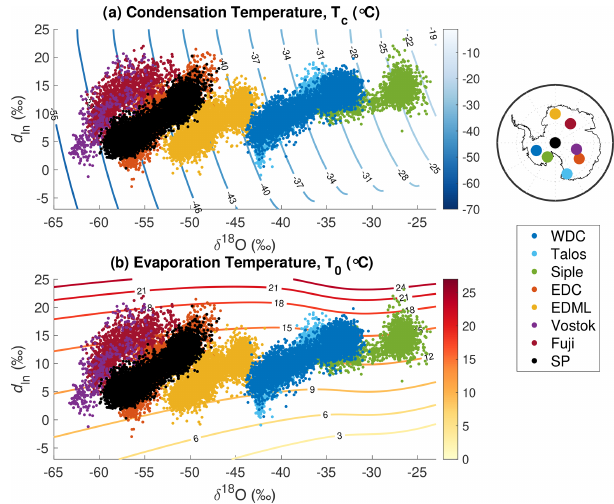
Figure A16. Inverted T 0 and T c surfaces as a function of modeled d ln and δ 18 O of precipitation as in Fig. 7. Overlain are pairs of d ln and δ 18 O measurements for eight different deep ice-core records, whose site locations are shown on the inset map. See Sect. 4.2 in the text for details on ice-core records.